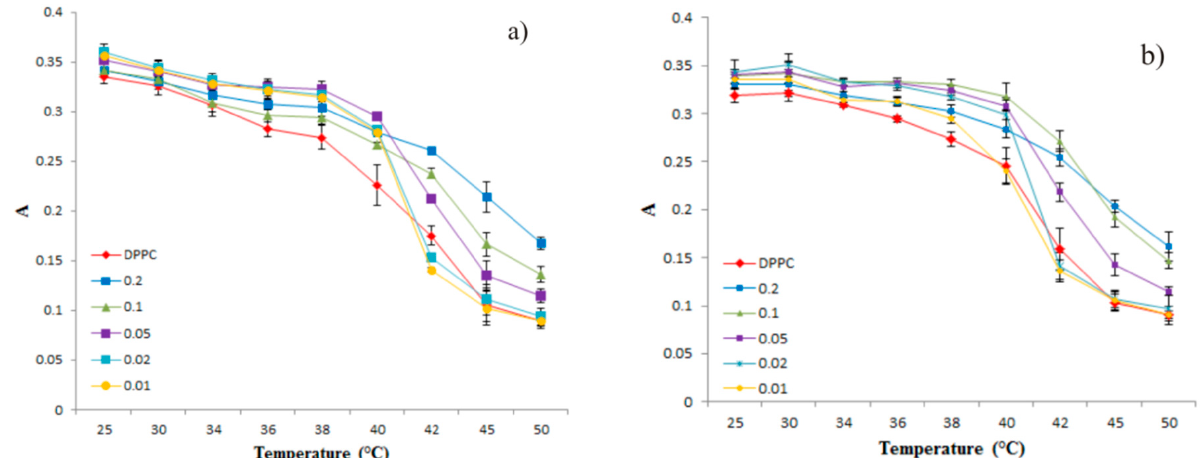
Figure 3. Values of anisotropy of DPH in liposomes DPPC (control) and mixed liposomes: acylglycerol 5 /DPPC ( a ) and acylglycerol 4/ DPPC ( b ) in six molar ratio of the tested acylglycerol to DPPC (n acylglycerold /n DPPC ): 0.01, 0.02, 0.05, 0.1, and 0.2, as a function of temperature.